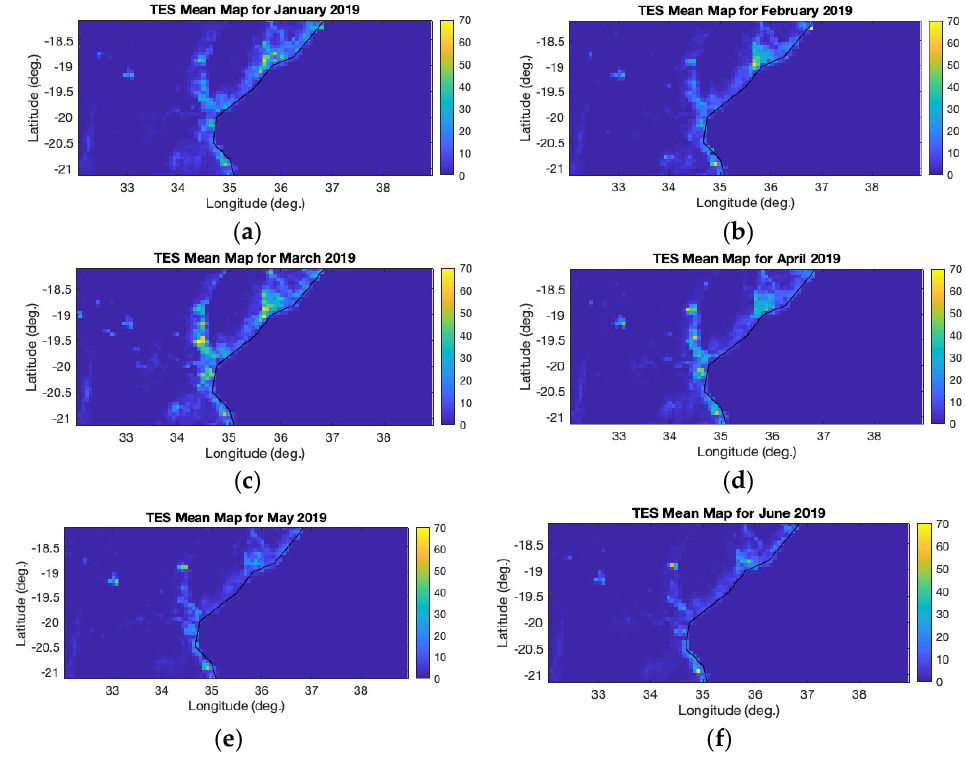
Figure 4. TES monthly means obtained from CYGNSS data for ( a ) January, ( b ) February, ( c ) March, ( d ) April, ( e ) May, and ( f ) June 2019.